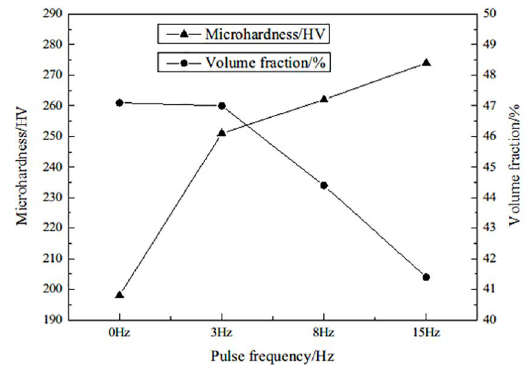
Figure 2. Performance comparison of aluminum brass alloy